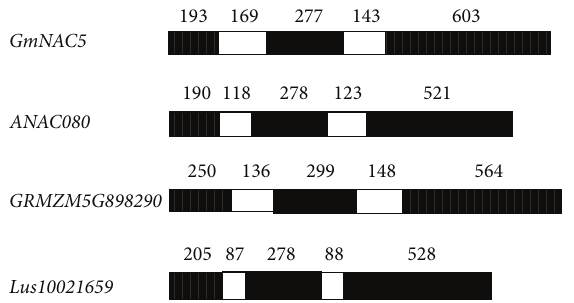
Figure 1: Schematic diagram of gene structures of GmNAC5 and its homologous genes in Arabidopsis thaliana ( ANAC08) , Zea mays ( GRMZM5G898290), and Linum usitatissimum ( Lus10021659 ). The black and white boxes indicate exons and introns,